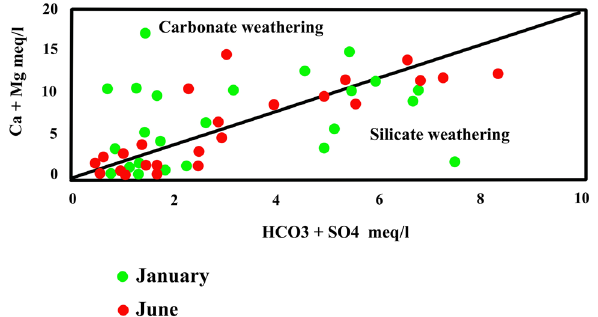
Fig. 12 Ca 2+ + Mg 2+ versus HCO 3− + SO 42+ plot for both January and